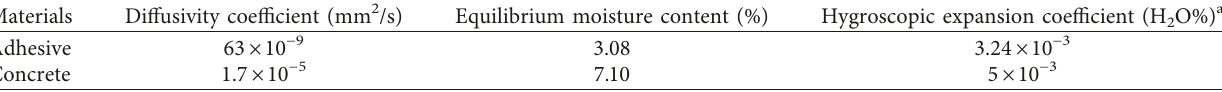
Table 1: Material properties used in the simulations.